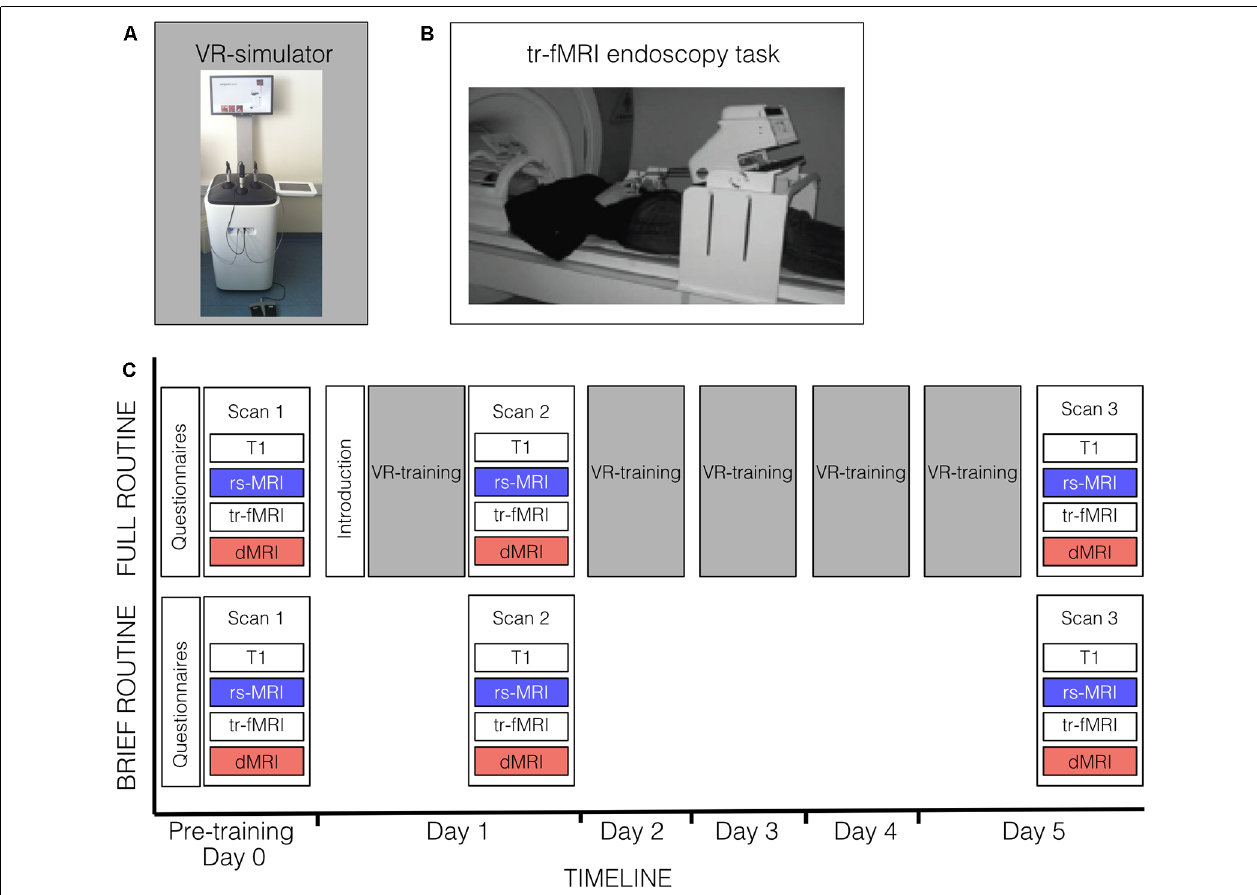
FIGURE 1 | Bimanual skill training and experimental procedure. (A) Endoscopic virtual reality (VR)-simulator set-up for bimanual skill training. (B) Set-up of in-scanner endoscopy task. Results for task-related activity changes during in-scanner endoscopy training are reported elsewhere (Karabanov et al., 2019). (C) Subjects of the full-routine group underwent resting-state fMRI (rs-fMRI), task-related fMRI (tr-fMRI) and diffusion MRI (dMRI) scans before (Scan 1) and after (Scan 2) the first VR-training session (approx. 45 min) on the endoscopic VR-simulator, followed by four consecutive days of VR-training, and received a third scan (Scan 3) after their last VR-training session. A 10-min introduction preceded the first VR-training session. Subjects of the brief-routine group got scanned in the same timeframe without receiving VR-training in endoscopy. Both groups completed a set of questionnaires before their first